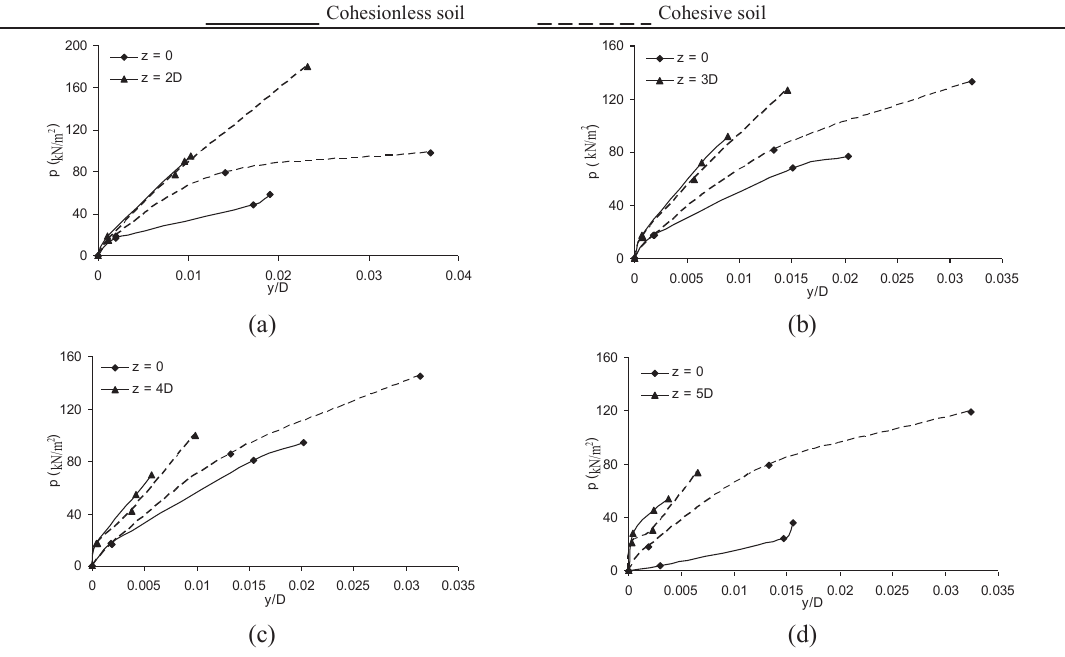
for EI magnitudes of EI = 1.4 × 105 kN m 2 , EI = 1.4 × 106